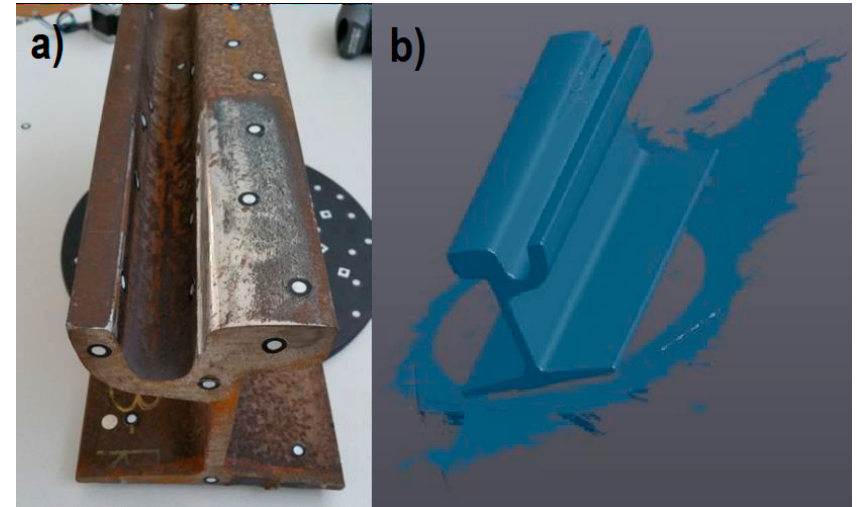
Figure 12. Sample worn track portion ( a ) and its 3D digital model ( b ).